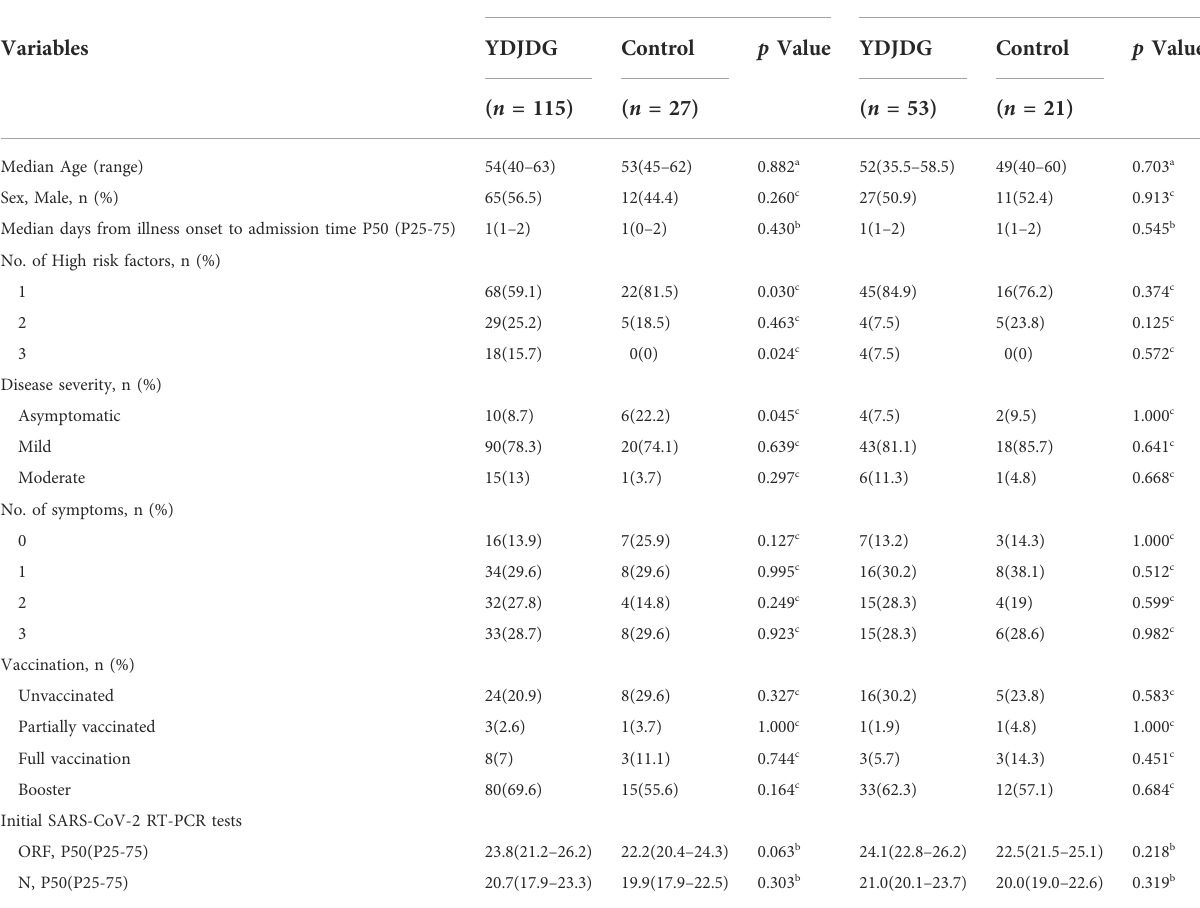
TABLE 2 Baseline characteristics of COVID-19 patients before and after propensity score matching between YDJDG and Control group. Before propensity score